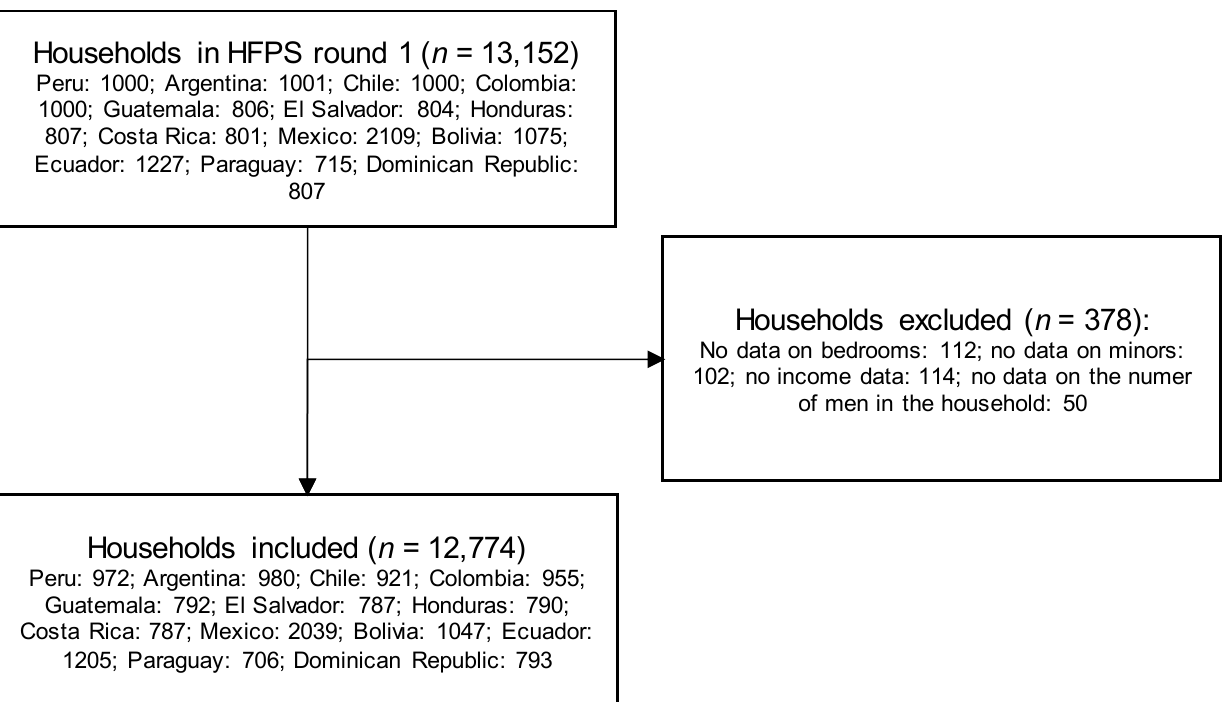
Figure 1. Flowchart of the selection of adults included in the study. HFPS: high-frequency phone surveys.